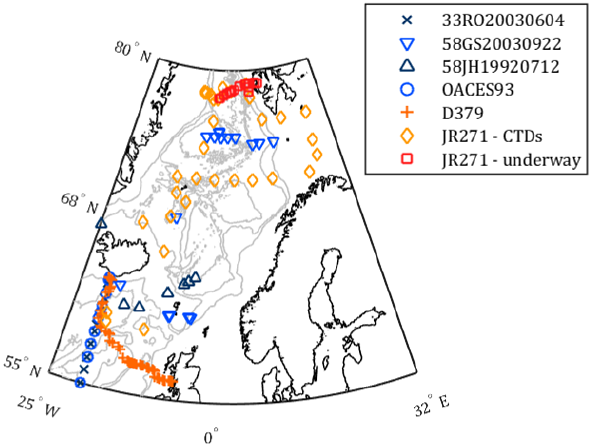
Figure 1. Sample locations for cruises D379 (orange plusses) and JR271 (CTD stations: gold diamonds; underway: red squares), along with nearby historical δ 13 C DIC data locations from the Schmittner et al. (2013) compilation: cruises 33RO20030604 (dark-blue crosses), 58GS20030922 (blue inverted triangles), 58JH19920712 (dark-blue triangles) and OACES93 (blue circles). Grey contours indicate bathymetry at 500m intervals from the GEBCO_2014 grid, version 20141103,